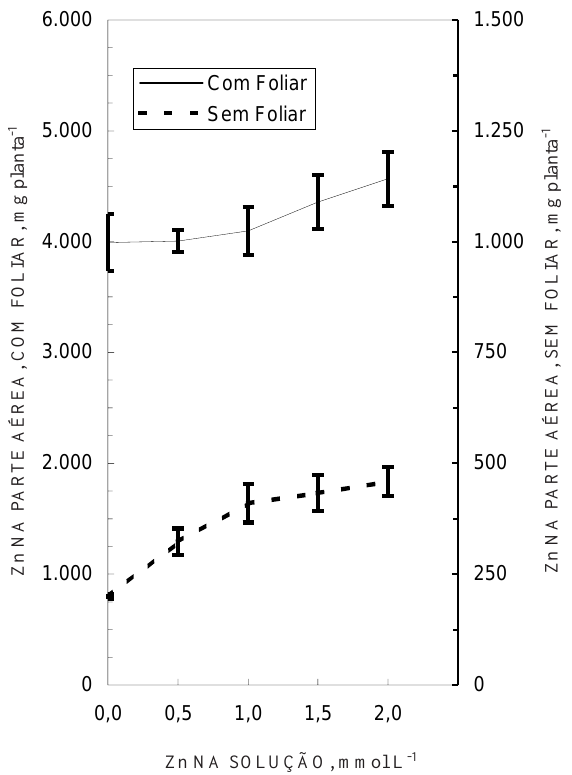
Figura 4. Conteúdo de zinco na parte aérea de plantas de milho, considerando a concentração do nutriente na solução nutritiva e a aplicação de zinco via foliar. As barras verticais mostram o desvio-padrão dos resultados.